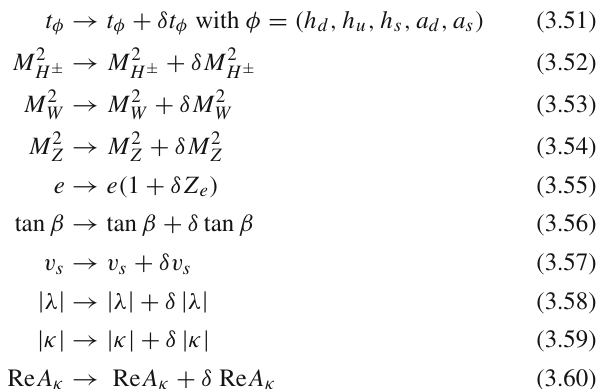
in detail. We furthermore include the dominant two-loop cor- rections of order O (α s α t ) [52] and O (α 2 available both for the real and for the complex NMSSM, to increase the precision for the phenomenological analysis presented in Sect.